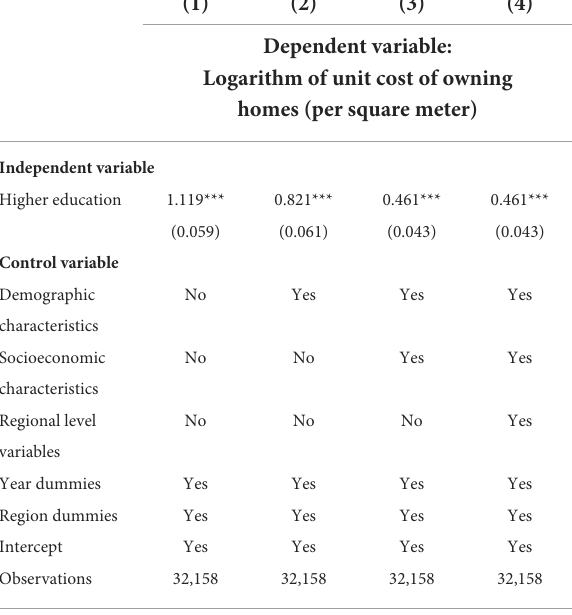
TABLE 9 Relationship between higher education and the unit cost of owning